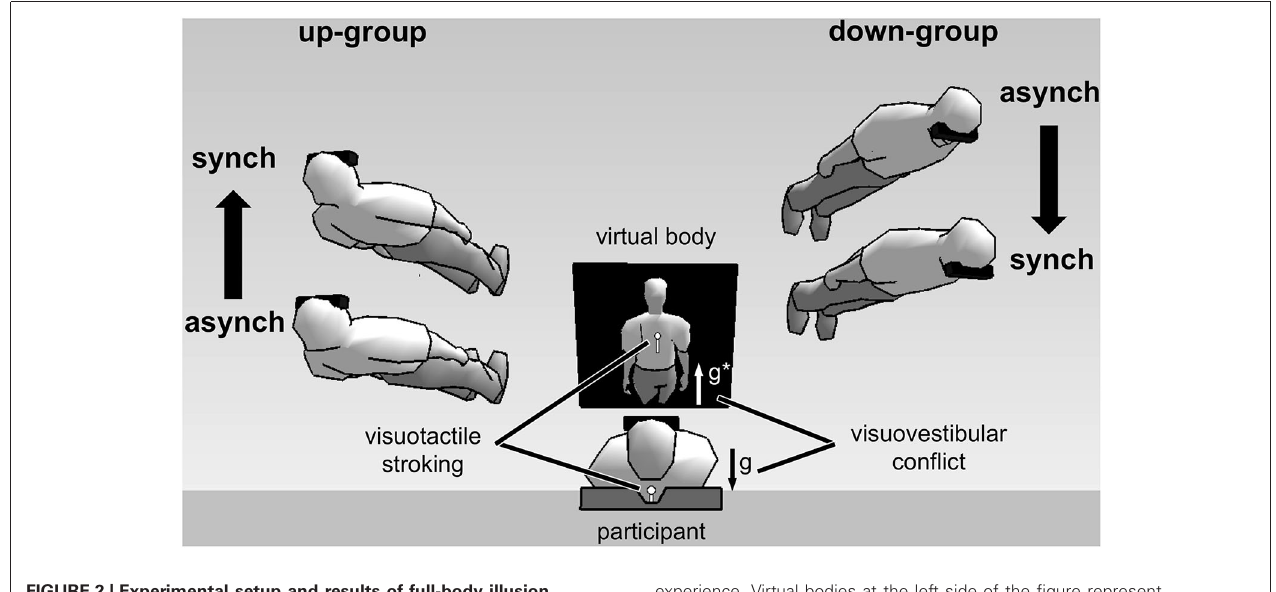
FIGURE 2 | Experimental setup and results of full-body illusion experiments using visuovestibular and visuotactile conflict (Ionta et al., 2011; Pfeiffer et al., 2013) . (Image center shows) A participant in supine posture views a virtual body on a head-mounted display. Vestibular otolithic signals about gravity (g) are in opposite direction with respect to visual gravitational signals (g*)—thus in visuovestibular conflict. Results showed individual difference in first-person perspective